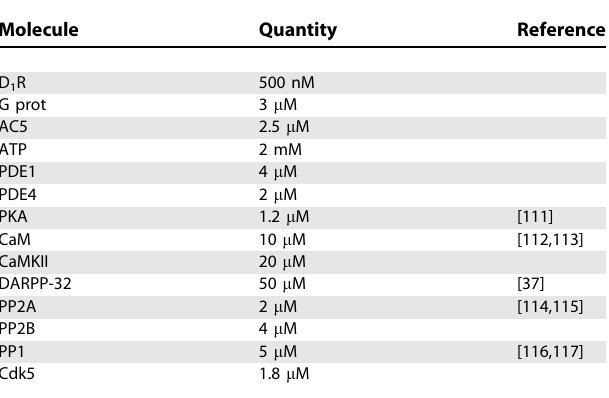
Table 4: Molecule Quantities Molecule Quantity Reference